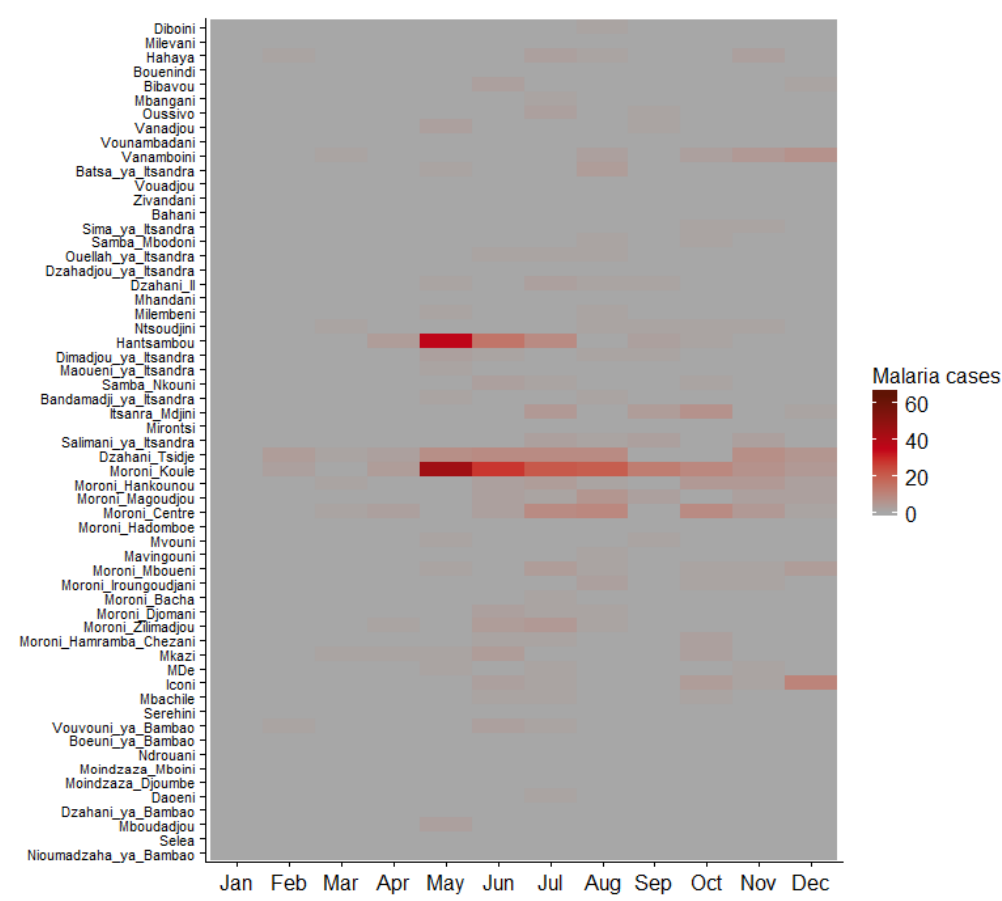
Figure 9. Monthly malaria cases by locality of the Centre health district in 2016 (localities are sorted from north to south).